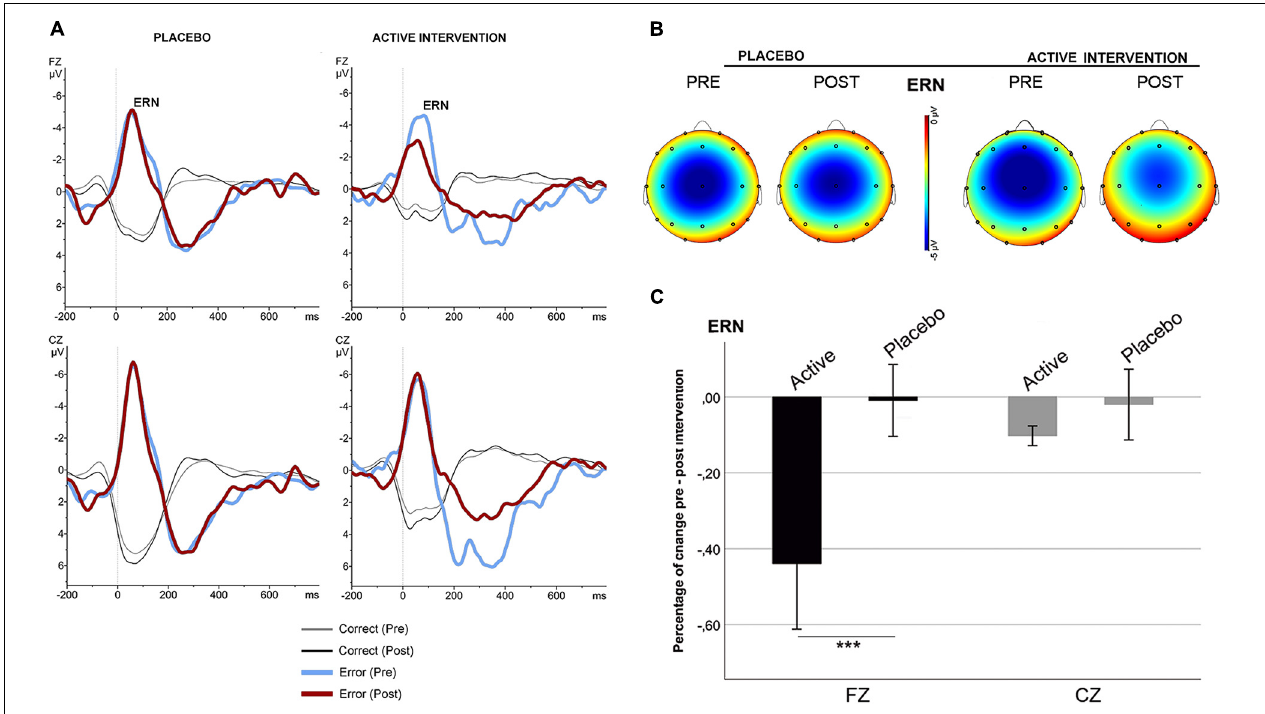
FIGURE 3 | Response-locked (ERN) grand average ERPs after correct (thin line) and error (thick line) responses in the stop-signal task for each group, pre (blue/gray) and post (red/black) intervention. (A) ERPs comparison in the placebo and in the active intervention group. (B) The topographical map shows the pre-post effect on the mean amplitude of the ERN. (C) Mean percentage of ERN change (in mV) between study groups. *** significantly different ( p <